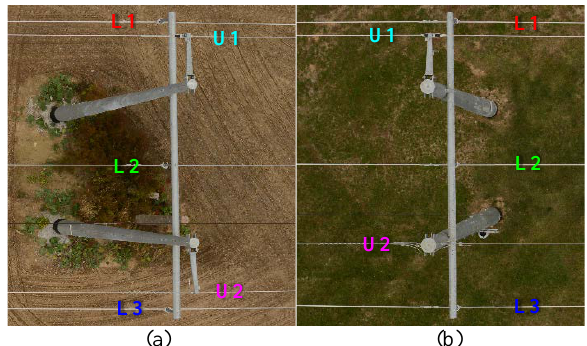
Figure 5. Top view on the towers at the end (a), and beginning (b) of the mapped transmission line section